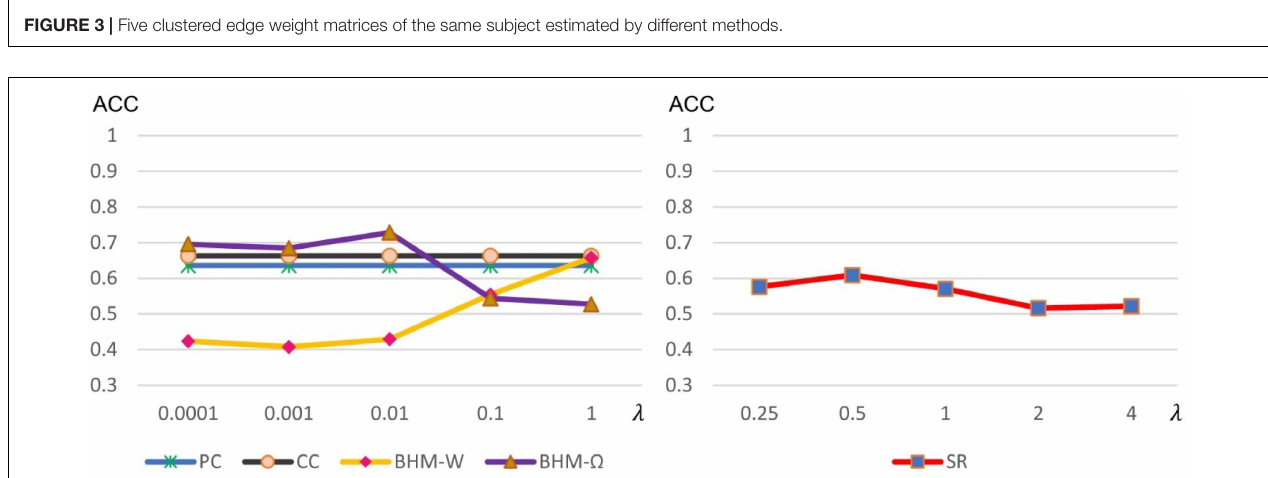
FIGURE 4 | Classification accuracy of ASD identification based on 5 BFNs estimated by PC, CC, SR, and BHM with 5 different parametric values. Although PC and CC have no optional parameters, in order to facilitate comparison, we visualize the accuracy of PC and CC in the left chart.